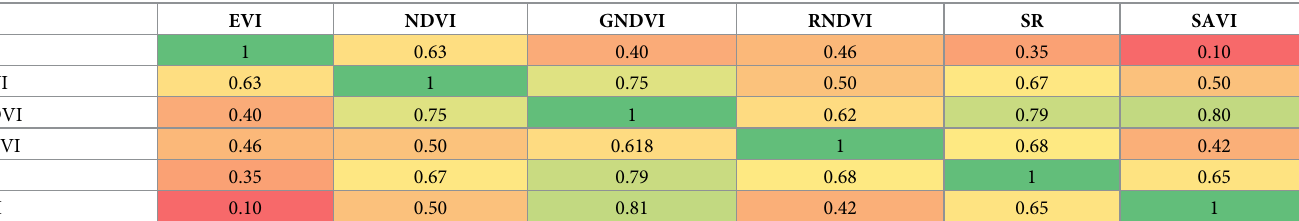
Table 3. Pearson correlation matrix among spectral vegetation indices of